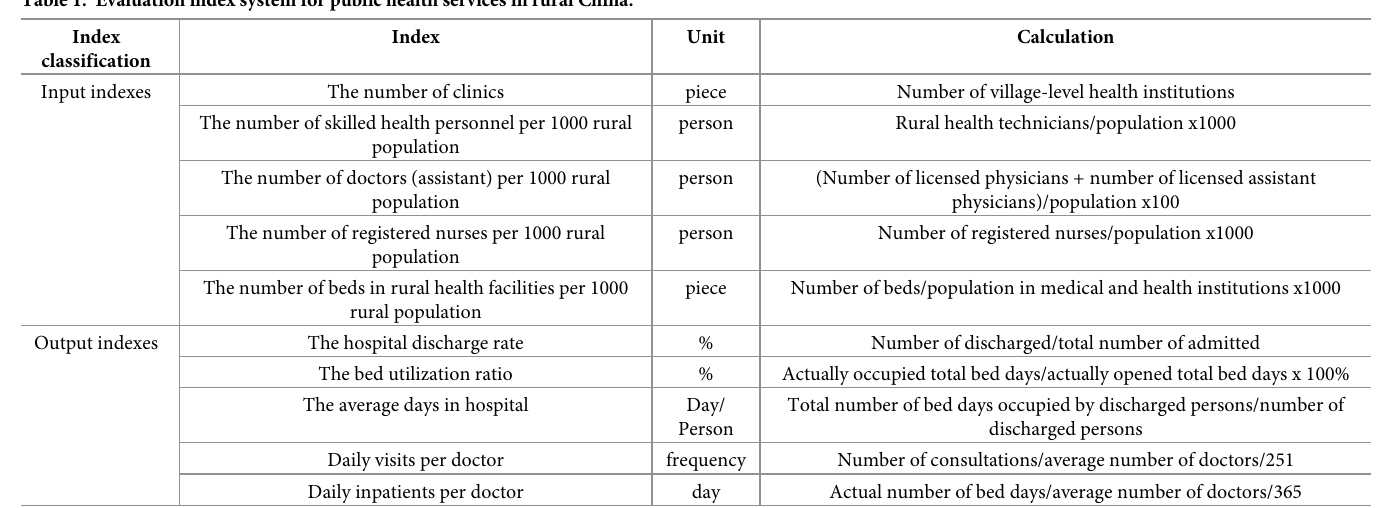
Table 1. Evaluation index system for public health services in rural